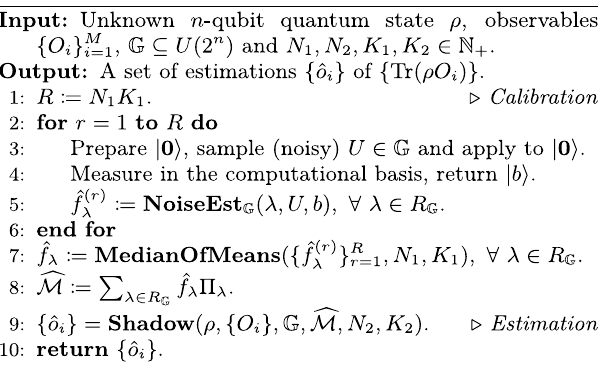
Algorithm 2. Robust shadow estimation ( RShadow